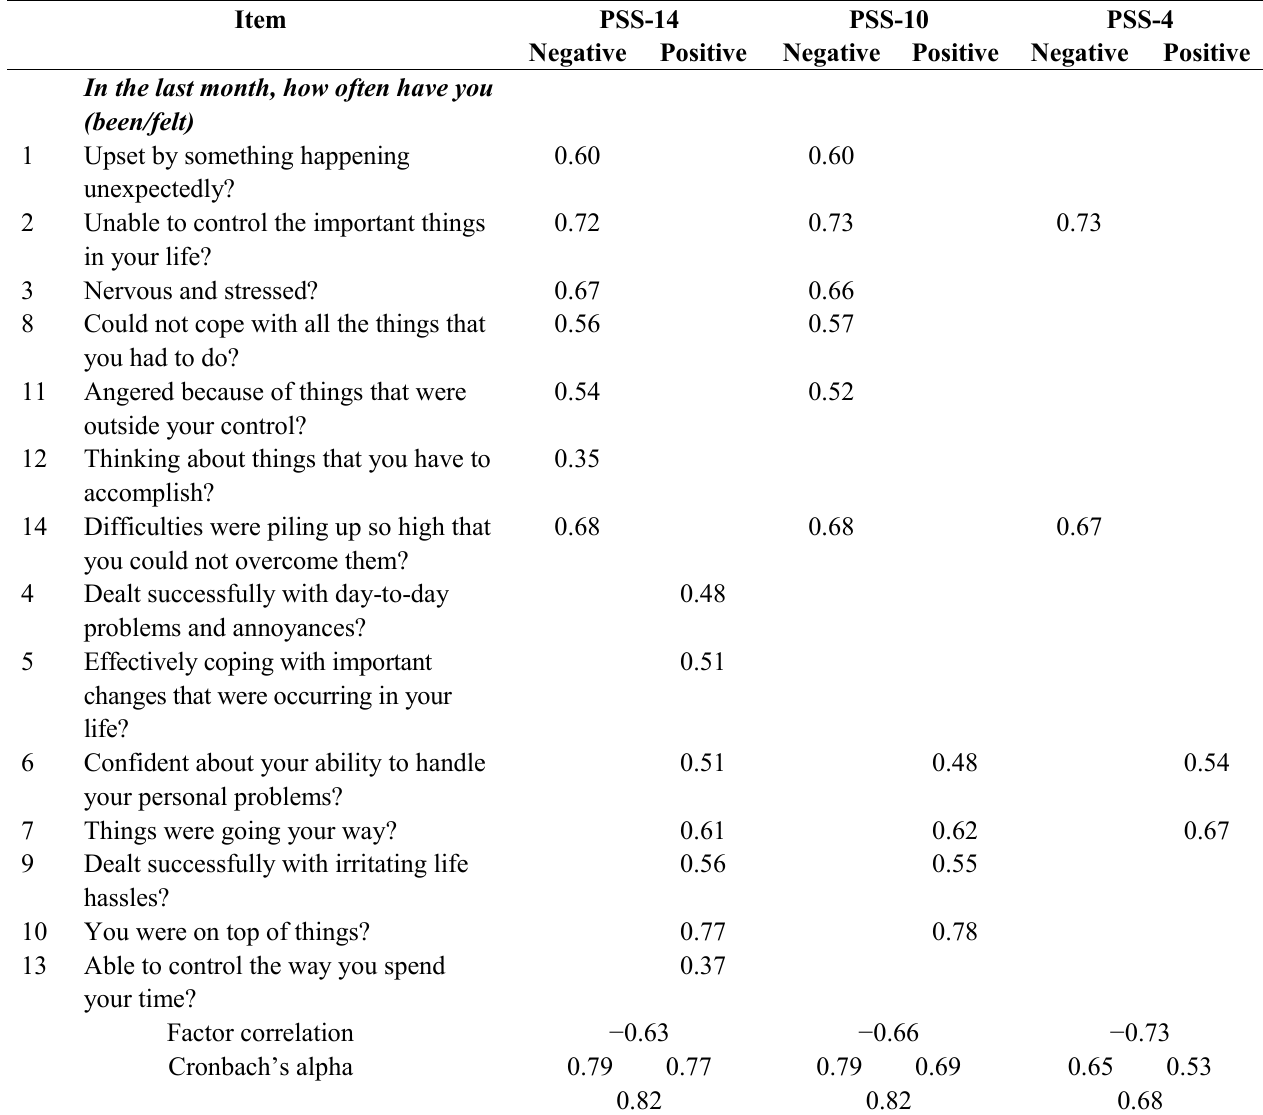
Table 2. Standardized factor loadings of the 2-factor models fitted to PSS-14, PSS-10 and